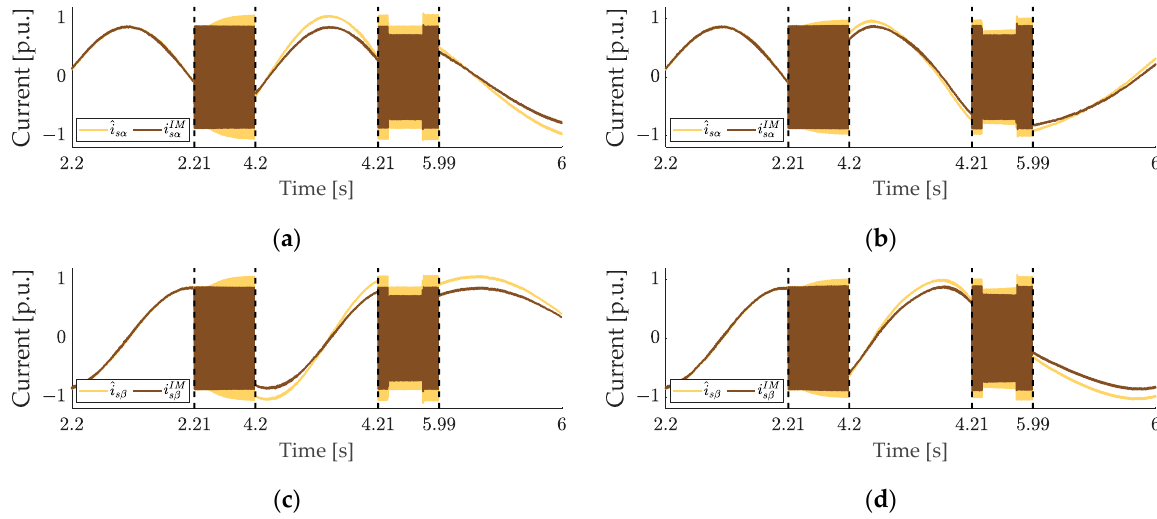
Figure 13. Estimated and measured stator current in α axis ( a , b ) and β axis ( c , d ) during CS fault in phase B for: k 0 = 1 ( G = 0) (a,c) and v 3 operation mode for k 0 = 1.4 ( b , d ); r r IM = var, r s IM = var.